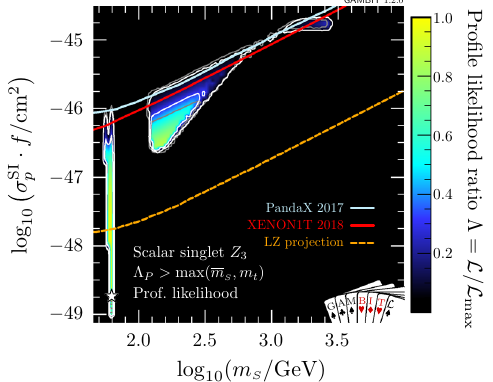
Fig. 10 Profile likelihood for the Z 3 scalar singlet model with the requirement Λ P > max ( m S , m t ) . Regions are shown as a function of m S and the spin-independent direct detection cross-section for scat- tering with protons, rescaled by the predicted relic abundance σ SI p · f , and compared to the exclusion bounds from various direct detection experiments. Contour lines indicate 1 σ and 2 σ confidence regions, and best fit points are indicated with stars. Shading and white contours show the result of including the 2018 XENON1T analysis [55], whereas grey annotations illustrate the impact of using the 2017 analysis [54] instead. Other lines indicate limits from PandaX [56] and XENON1T [55], and the projected sensitivity of LZ [94]